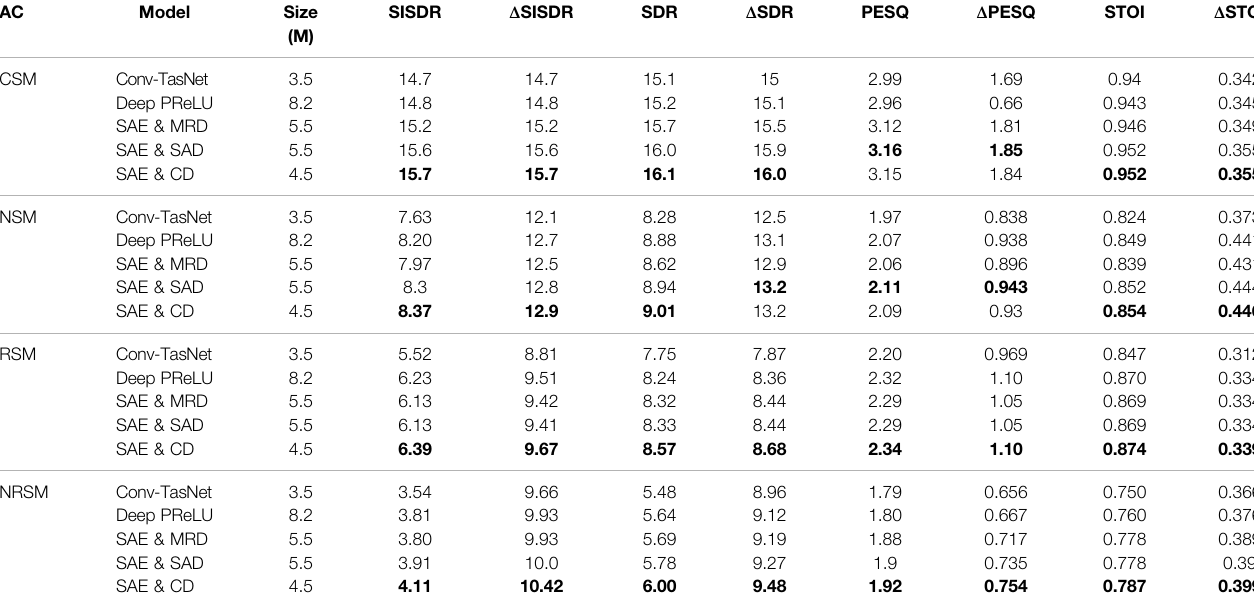
TABLE 6 | Comparison of MHA and encoder and decoder against the deep convolutional encoder/decoder Cont-TasNet model proposed by Kad ı o ğ lu et al. (2020). Bold indicates the best performing model for each acoustic condition and metric. AC